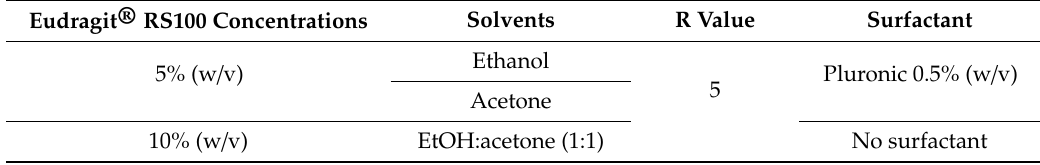
Table 1. Parameters and conditions used for the Eudragit ® RS100 NP synthesis in batch reactors. R value stands for antisolvent/solvent ratio.